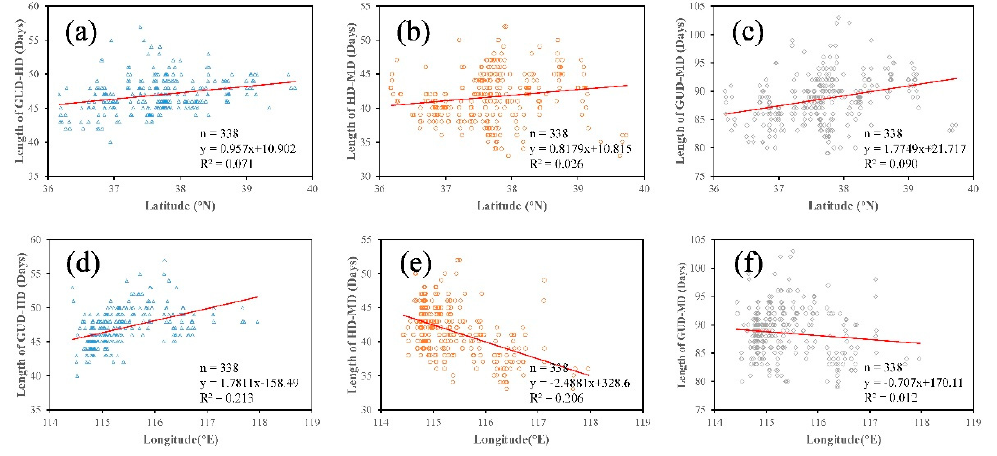
Figure 11. The relationships between ( a ) the length of time between GUD and HD, and latitude, ( b ) the length of time between HD and MD, and latitude, ( c ) the length of time between GUD and MD, and latitude, ( d ) the length of time between GUD and HD, and longitude ( e ), the length of time between HD and MD, and longitude, and ( f ) the length of time between GUD and MD, and longitude.